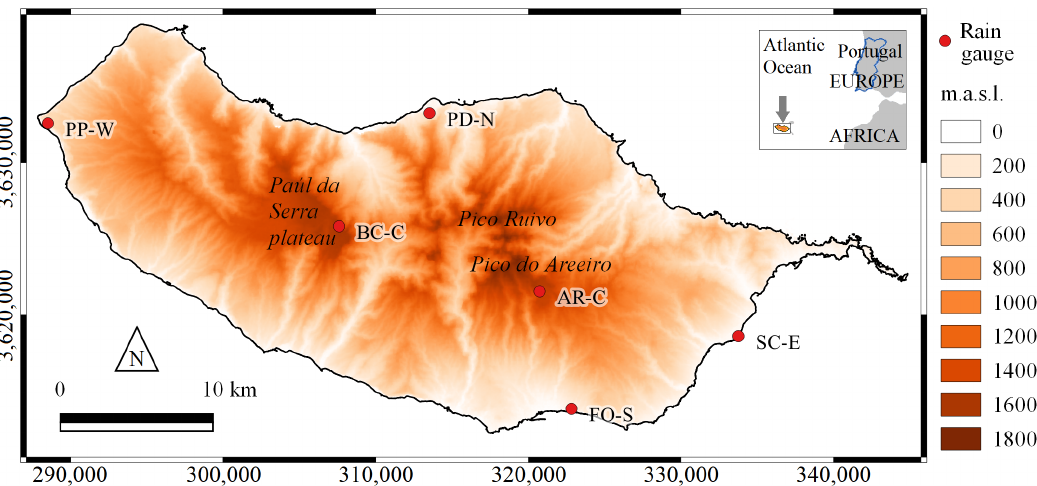
Figure 1. Coordinates WGS84 (UTM zone 28N) and relief of Madeira Island, Portugal. Spatial distribution of the six rain gauges used in this study are depicted by bullets and their identification codes (description in Table 1).